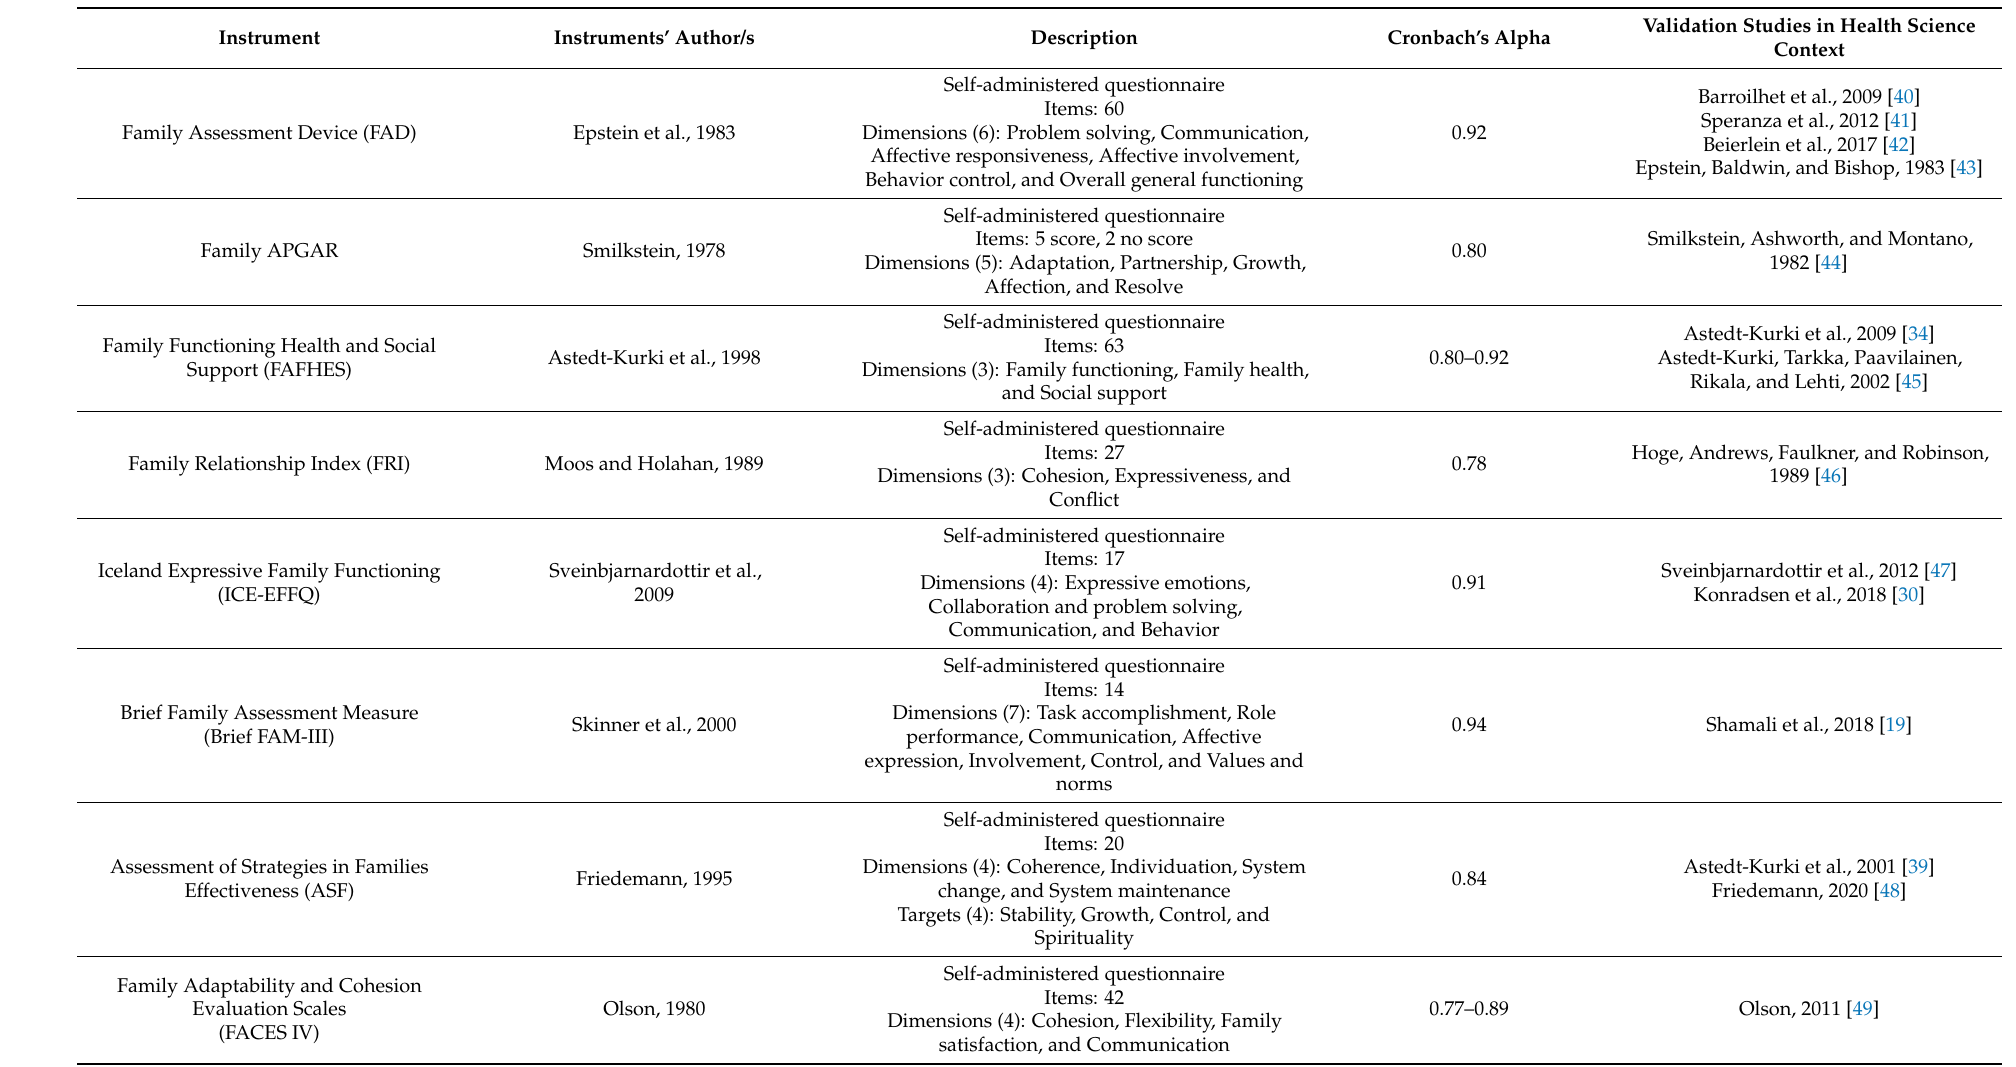
Table 2. Description of family functioning measuring